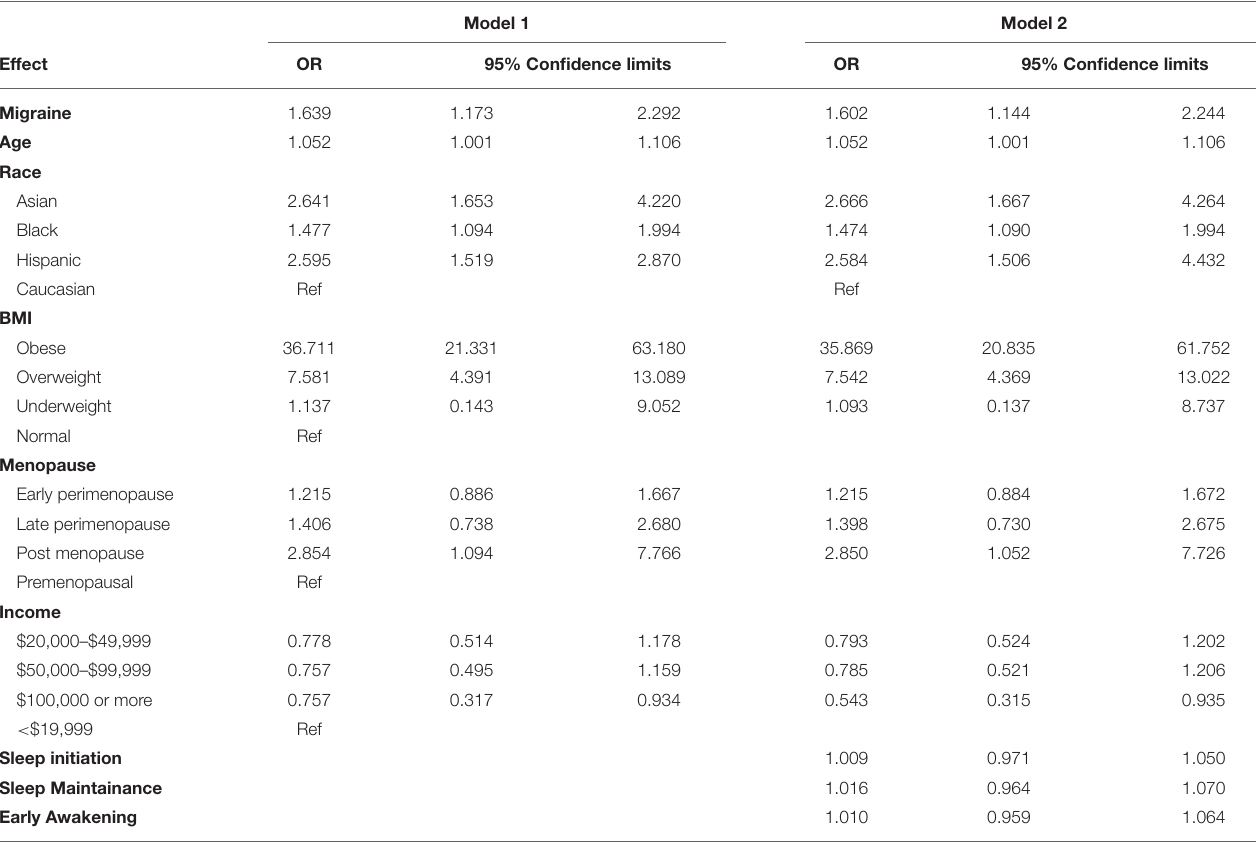
TABLE 2 | Ordinal logistic regression models with allostatic load on migraine and other predictors.